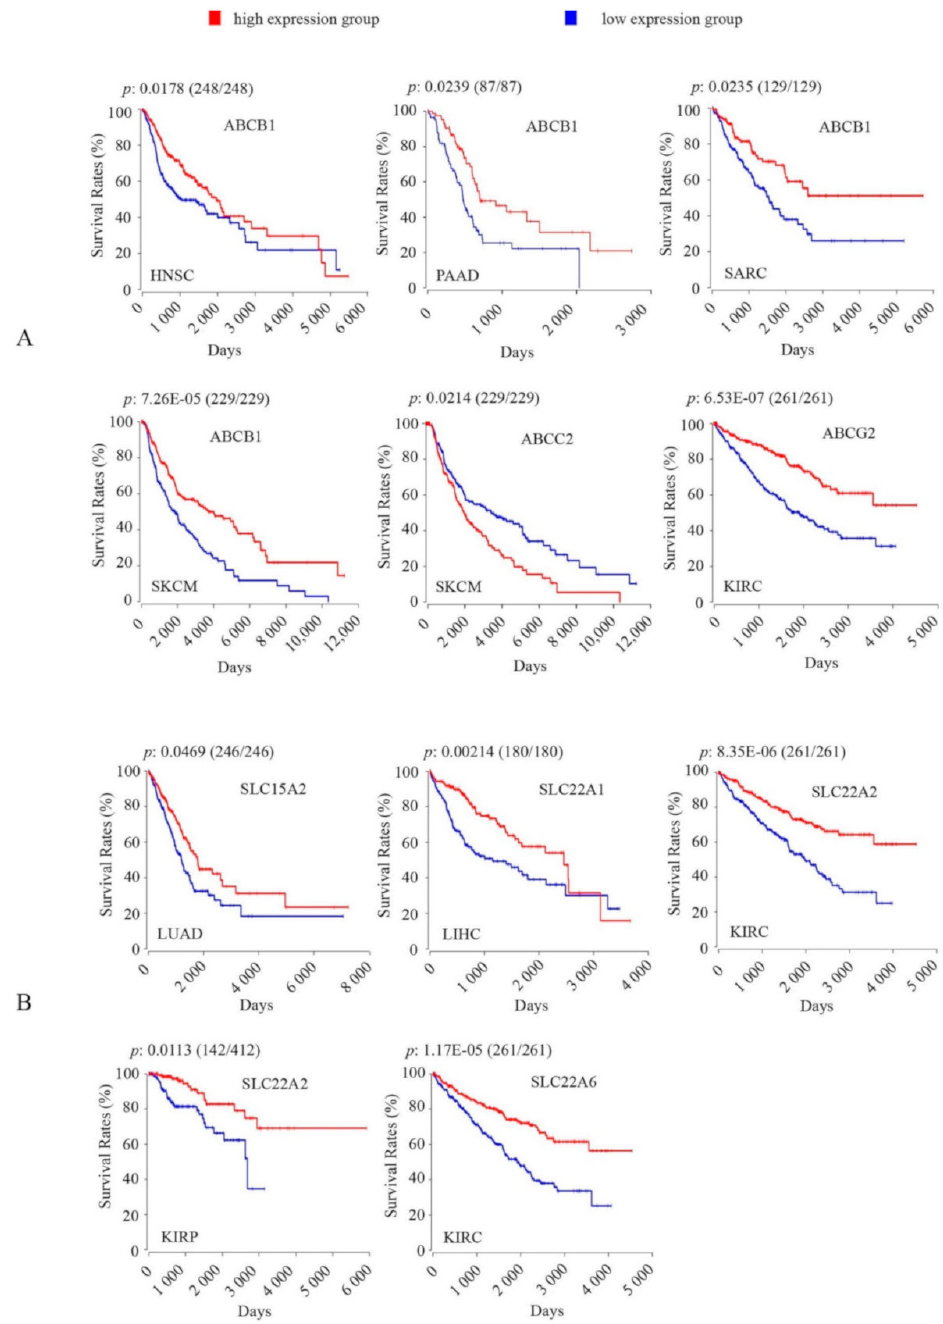
Figure 4. Kaplan-Meier survival analysis and Logrank test show significant associations of intratumoral expression levels of core ADME genes coding for ABC ( A ) and SLC ( B ) drug transporters with overall survival rates in TCGA cancers. For Kaplan-Meier survival analysis, the patients were separated into high-expression group (upper 50 percentile, red curve) and low-expression group (lower 50 percentile, blue curve) by gene expression levels in each TCGA cancer type as indicated. The number of patients in each group was given in bracket following the p -value. A Bonferroni-corrected cuto ff logrank p -value of < 0.05 indicates statistical